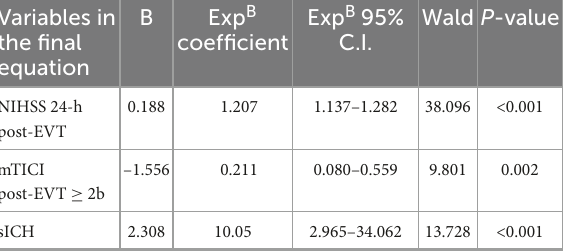
procedure: 26.2 vs. 7.4% and higher rates of cancer